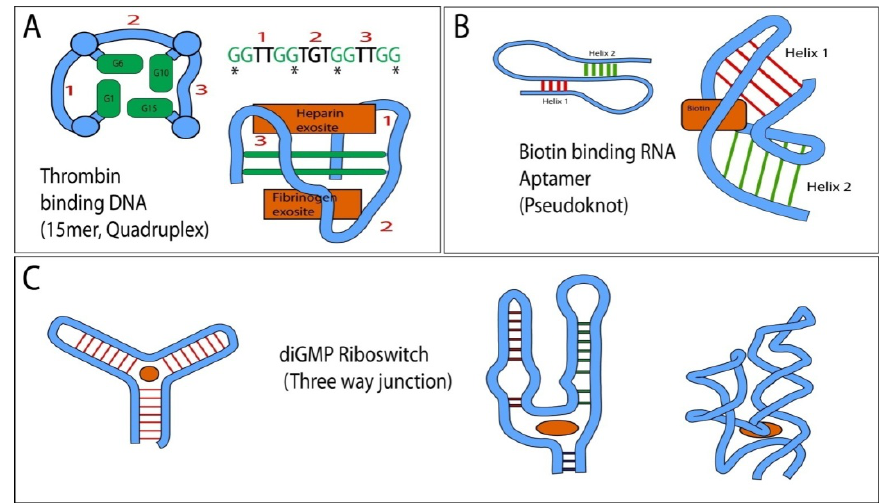
Figure 2. Topologies frequently found in RNA and DNA aptamers and their simplified 3D structures with indicated location of ligand binding sites (orange). ( A ) 15 nucleotide core of the Thrombin binding quadruplex DNA aptamer [42–44]. The central structural feature are two layers of quadruplex guanosines, derived from the repeating GG motif of the primary sequence (interacting guanosines in left representation are marked by “*” in the primary sequence). The aptamer can interact with either the fibrinogen or heparin exosite and crystallized “sandwiched” between two thrombin molecules. The connectivity of the intervening loops (1–3) differs between quadruplexes and loop sequences provide binding specificity; ( B ) Biotin binding pseudoknot RNA aptamer (adapted from [45]). The interface of the two tilted helices provides a cavity in which biotin binds; ( C ) Left: Generalized topology of a three way junction and identification of its central ligand binding cavity. Right: Simplified 2D and 3D structure of the diGMP binding Riboswitch (adapted from